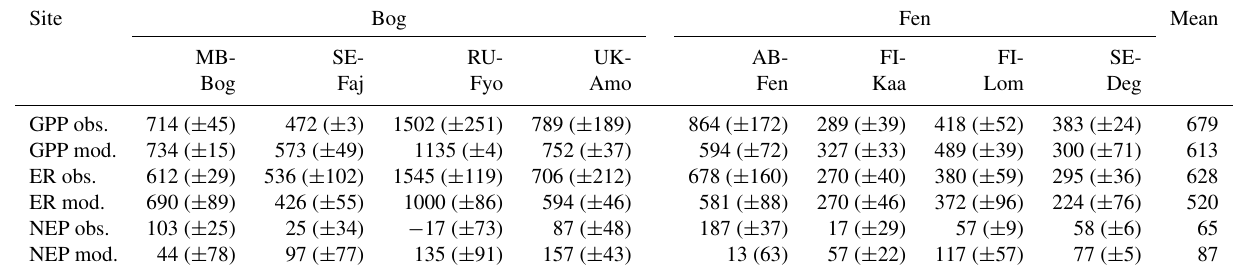
Table 7. Summary of observed (obs.) and modelled (mod.) mean annual GPP, ER, and NEP of the eight sites with standard deviation shown in brackets; units are gCm − 2 yr − 1